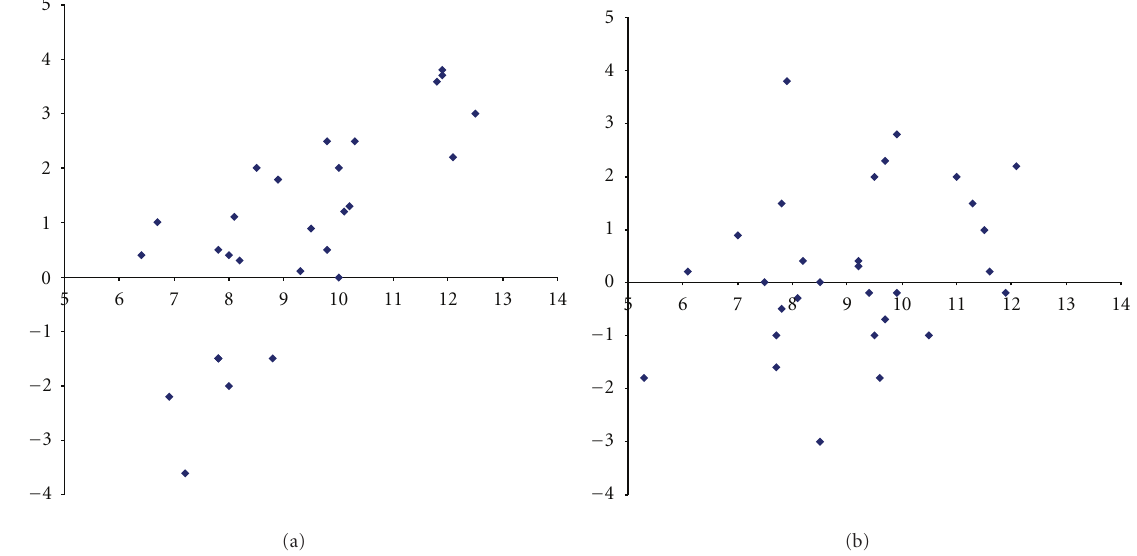
Figure 3: (a) Bland-Altman plot showing di ff erences for the sagittal mobility (cm) at the first measurements ( Y -axis) made by rater A and rater B versus the mean values of these di ff erences ( X -axis). Every dot represents one subject. (b) Bland-Altman plot showing di ff erences for the sagittal mobility (cm) at the second measurements ( Y -axis) made by rater A and rater B versus the mean values of these di ff erences ( X -axis). Every dot represents one